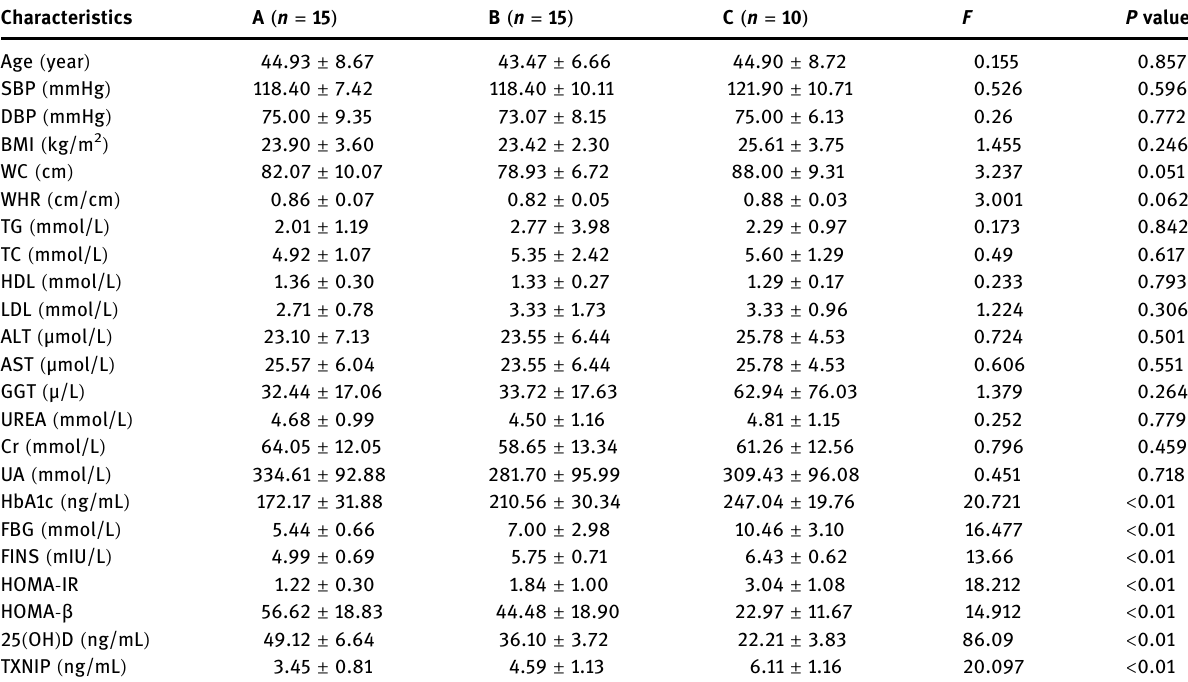
Table 1: Demographic and clinical information of participants